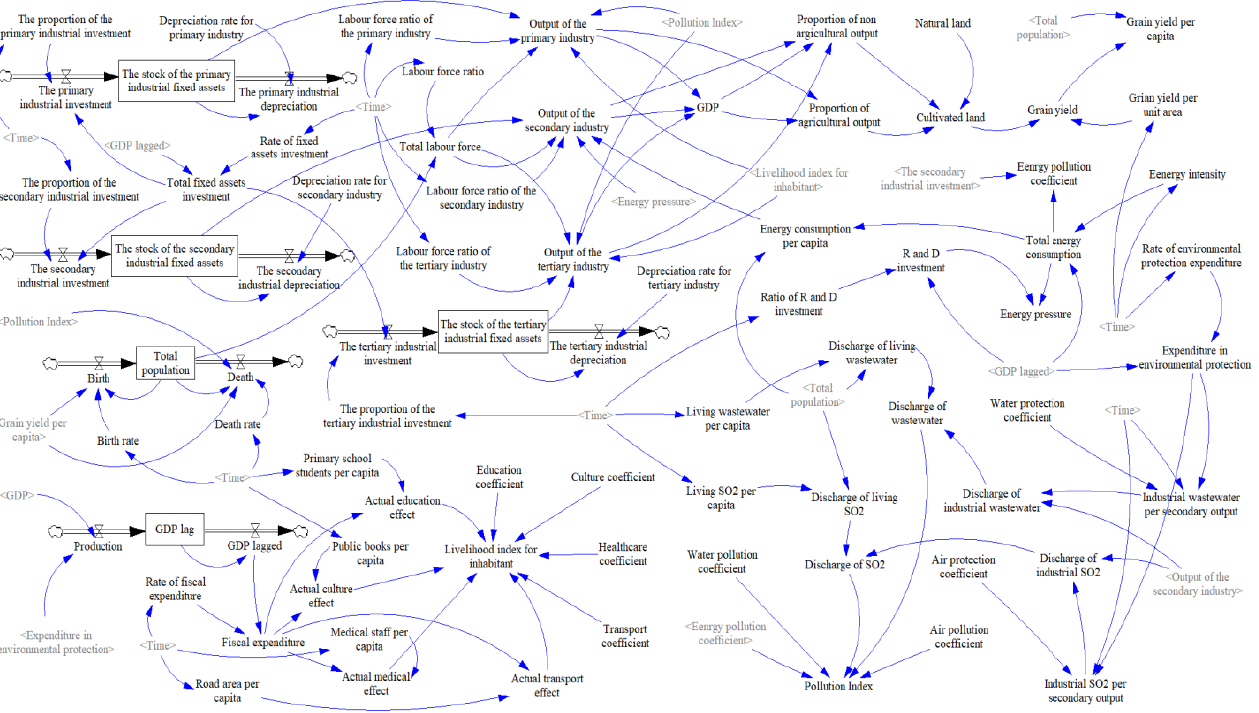
Figure 2. Stock and flow chart of the urban system.